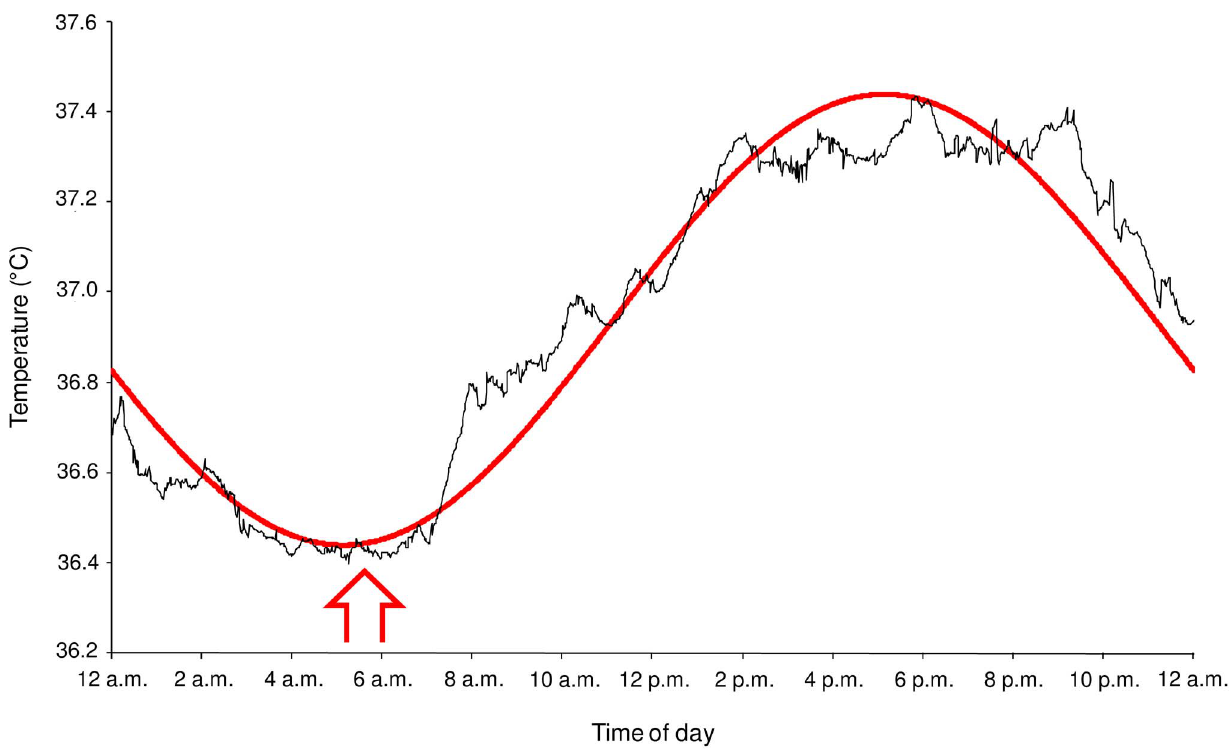
Figure 2. Circadian rhythm of gastrointestinal temperature. Mean values (black line) recorded every 60 s during 24-h period are shown. The mean best-fit curve (red line) between the experimental data and the cosine curve of the 20 participants is shown ( r =0.97). Red vertical arrow illustrates the beginning of the three morning test sessions. 5:08 6 0:19 a.m., and a MESOR of 36.94 6 0.08 u C. The peak-to- trough amplitude of the rhythm was 1.0 6 0.04 u C (Figure 2).